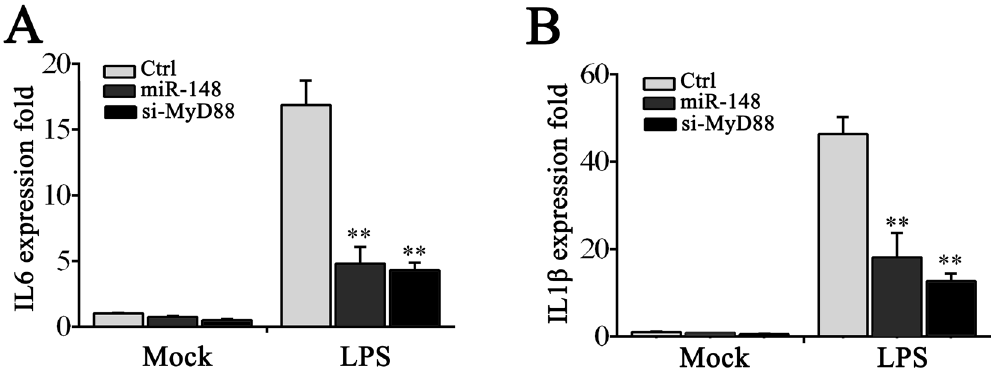
Figure 6. siRNA interference with MyD88 in miiuy croaker macrophages. Miiuy croker macrophages were transfected with control siRNA (si-Ctrl) or siRNA against MyD88 (si-MyD88). After 24 h transfected, miiuy croaker macrophages were then stimulated with LPS for another 24 h and the mRNA expression of IL-6 ( A ) and IL-1 β ( B ) were determined, respectively. Mock group represents the macrophages without stimulation. The mRNA expression profile was normalized to the expression of β -actin and represented as fold induction relative to the expression level in control cells that was set to 1. Data was presented as the means ± SE from three independent triplicated experiments. ** p < 0.01 versus the